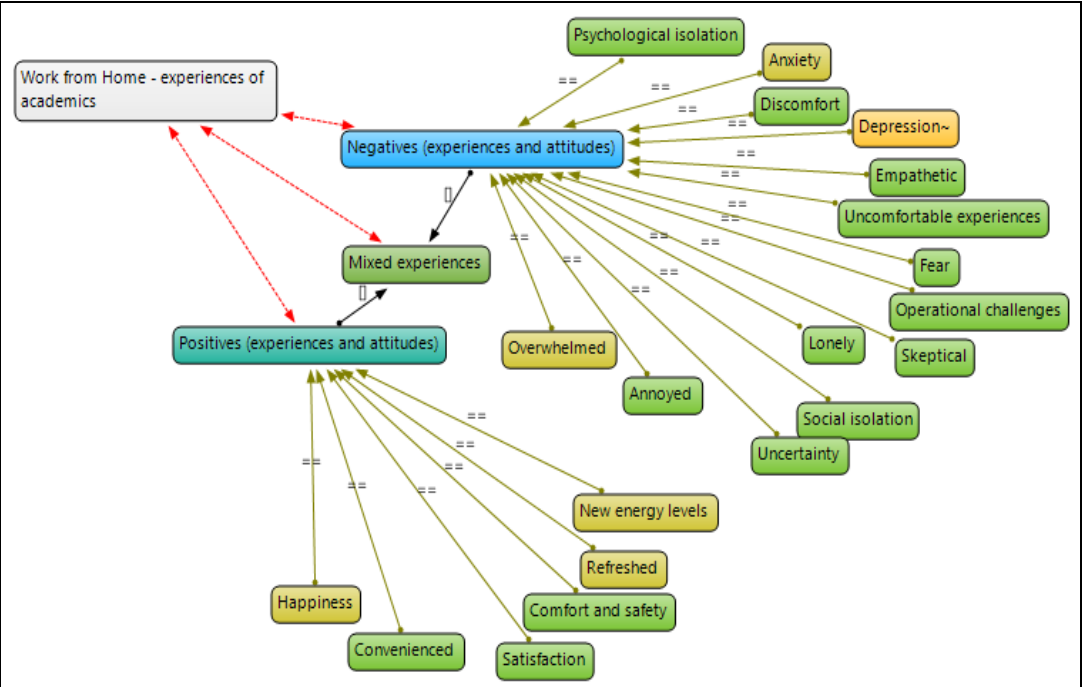
Figure 2. Academics’ lived experiences of virtual work arrangements.